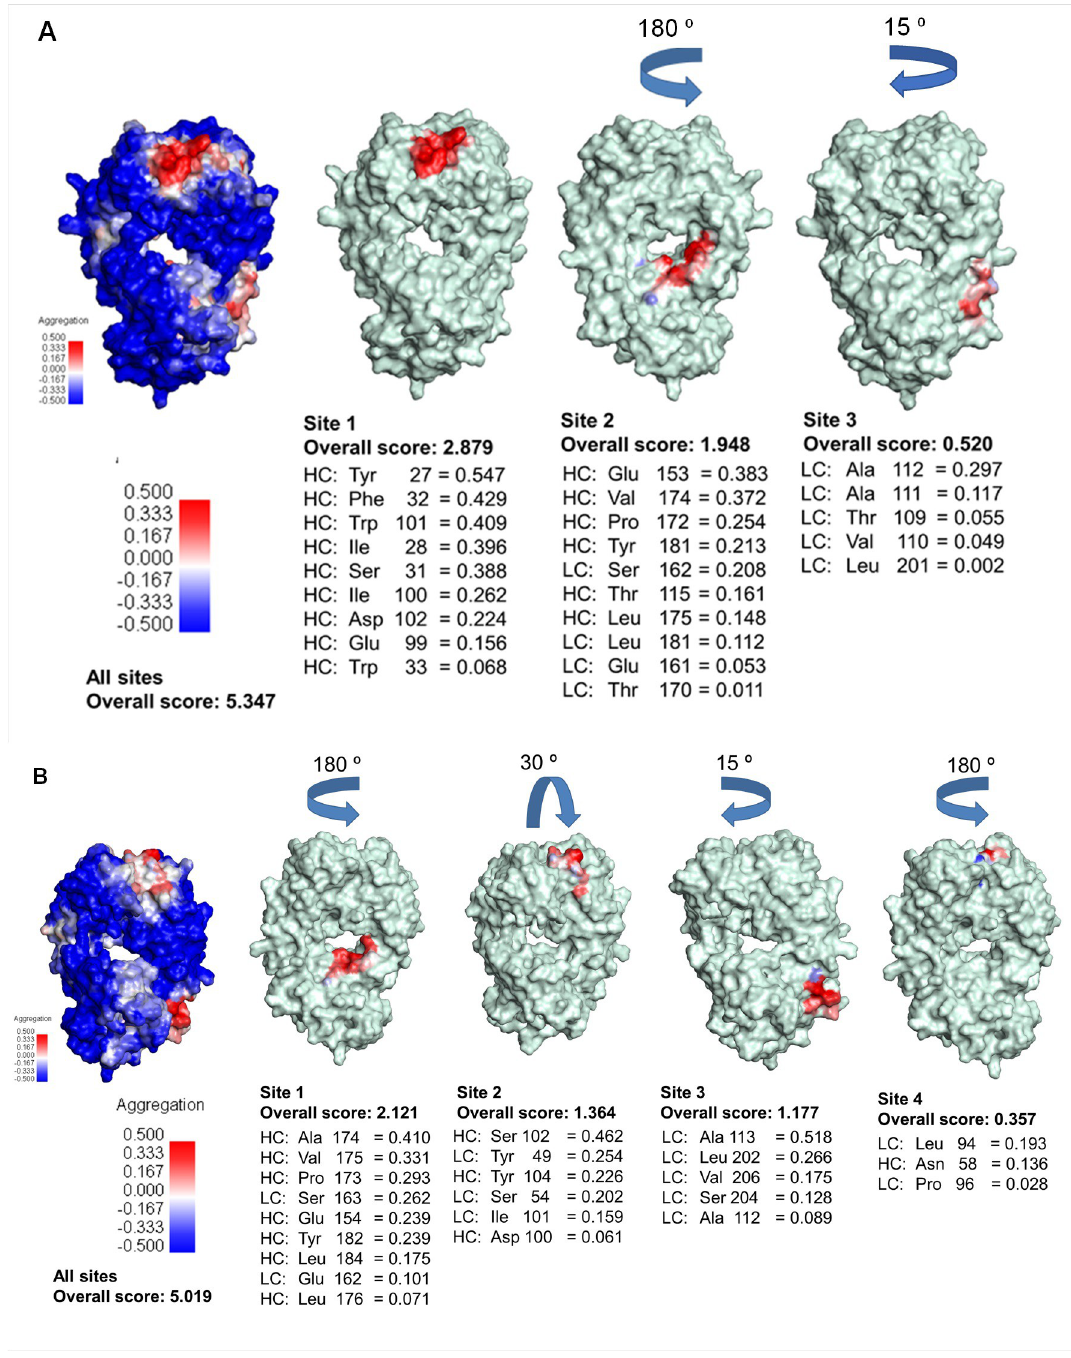
Fig 1. Spatial aggregation propensity of the Fab region of E559 (A) and 62-71-3 (B) at R = 10 Å . The SAP values at R = 10 Å were mapped on the Fab fragments. The red patches indicate sites that have a high propensity for aggregation while the blue patches are less prone to aggregation. The APRs were ordered by their contribution to the overall aggregation